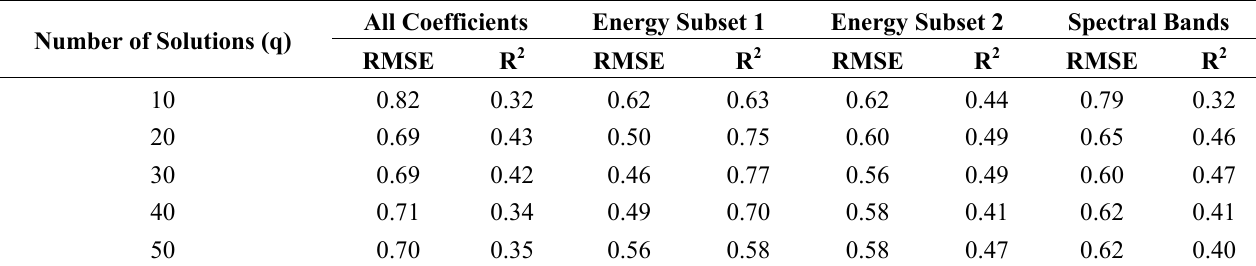
Table 2. Results from LUT inversion. The first column shows the total number of solutions selected by least RMSEr to calculate the median LAI value. The other columns show the RMSE and R 2 between measured and estimated LAI by inversion using ALL COEFFICIENTS, ENERGY SUBSET 1, ENERGY SUBSET 2, and SPECTRAL BANDS respectively.